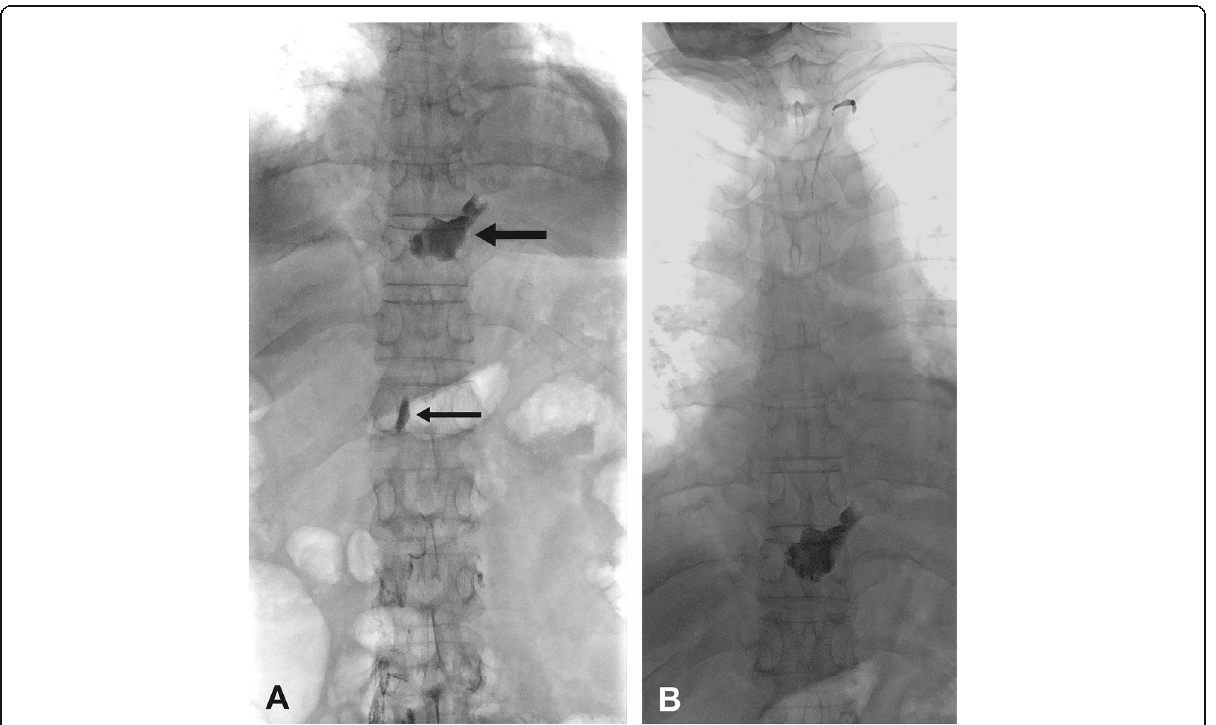
Fig. 1 Transnodal lymphangiography. a Cisterna chyli at the T12 vertebral level (small black arrow) and a lymph leakage of the thoracic duct at